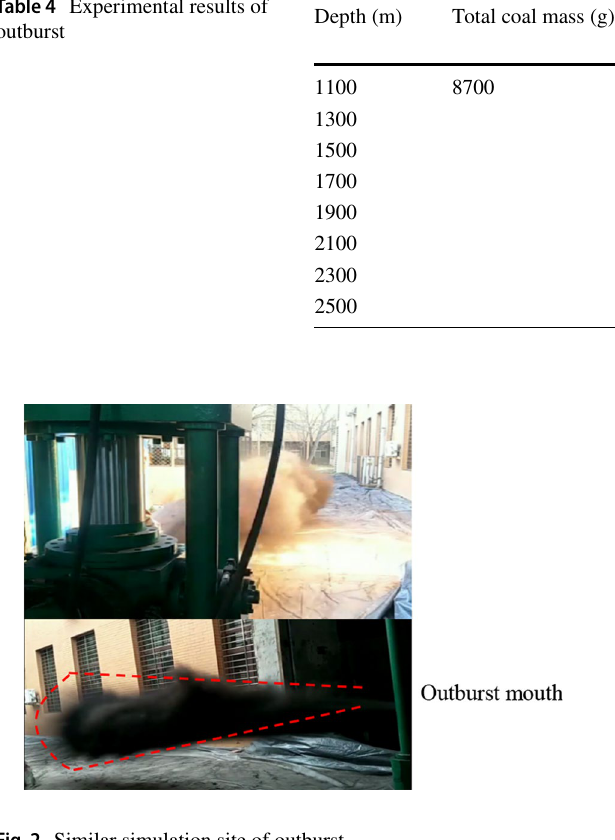
Fig. 3 Variation of relative outburst intensity and critical gas pressure with